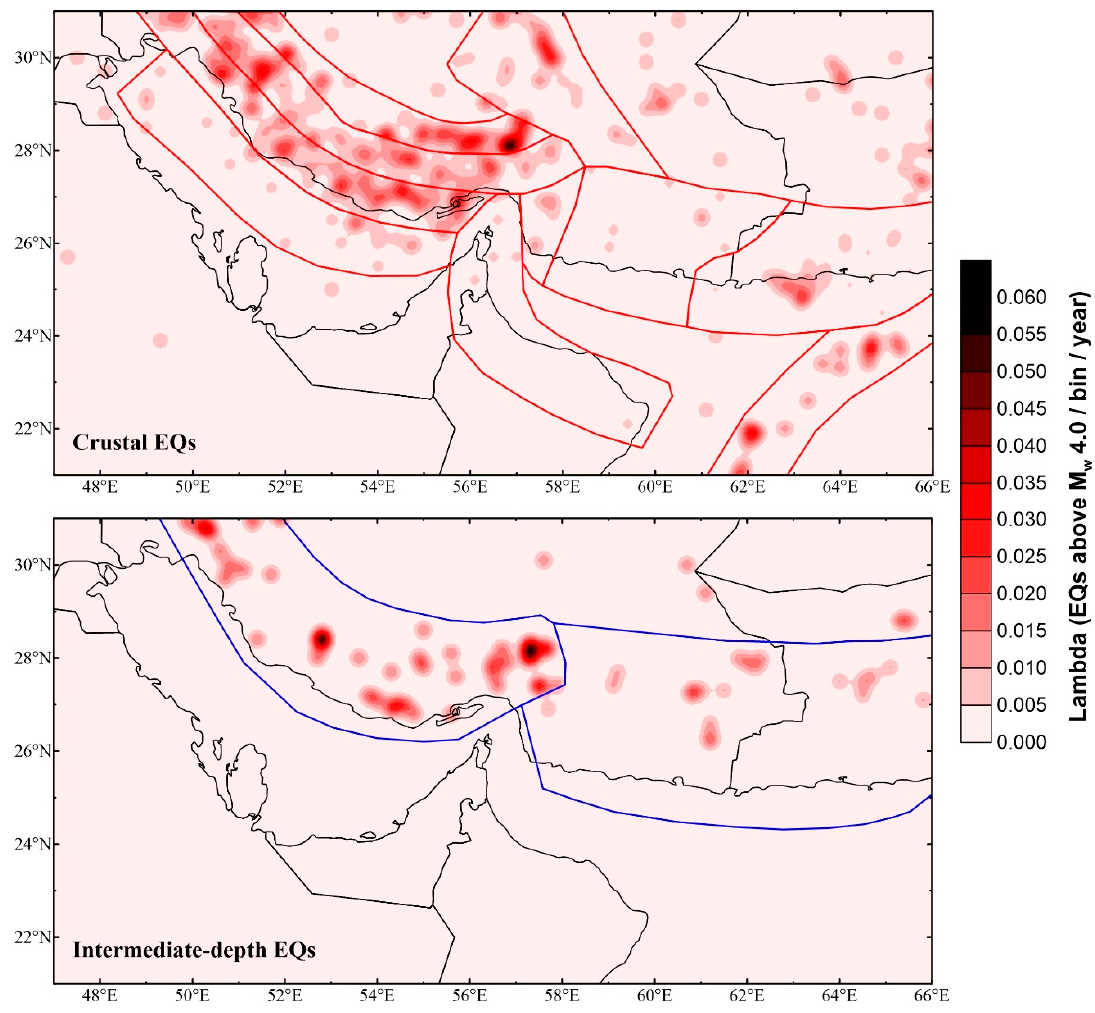
Figure 3. The annual number of earthquakes above Mw 4.0 for each cell / bin that is considered for the spatially-smoothed seismicity model for both crustal (upper plot) and intermediate-depth (lower plot) sources (imported from Sawires et al. [2] model).